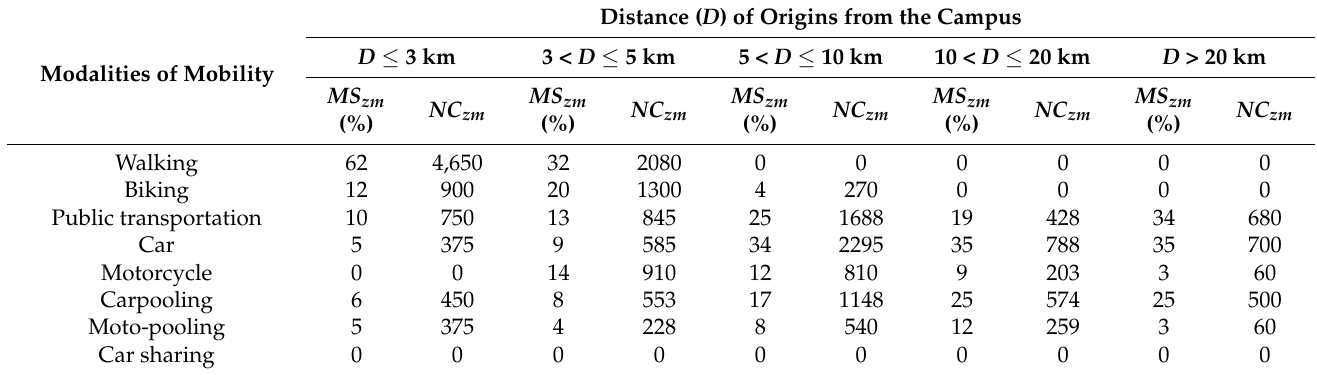
Table 2. Share of commuters ( MS zm ) and related numbers ( NC zm ) per zone and per